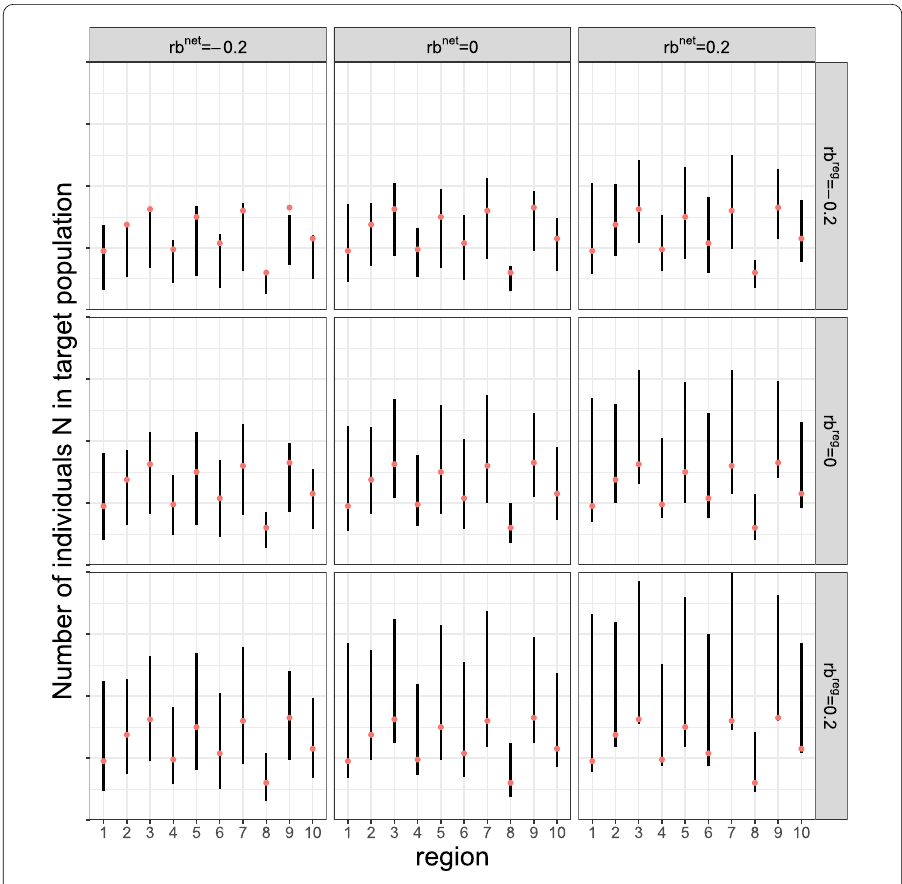
Figure 14 Credible intervals for the initial number of individuals N 0 per region. Credible intervals (prob = 95%) for the initial number of individuals N 0 per region compared to true values (in red) computed according to the distribution in eq. (26) with the RSS geolocation model and uniform prior and different values of rb net and rb reg